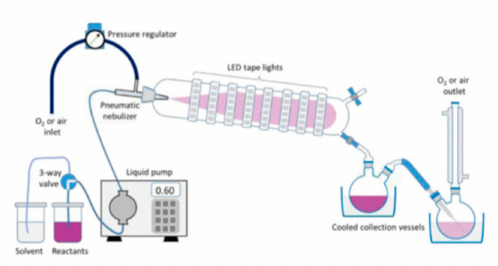
Figure 2. Image of the nebulizer-based photo-reactor (reproduced with permission from [27]).